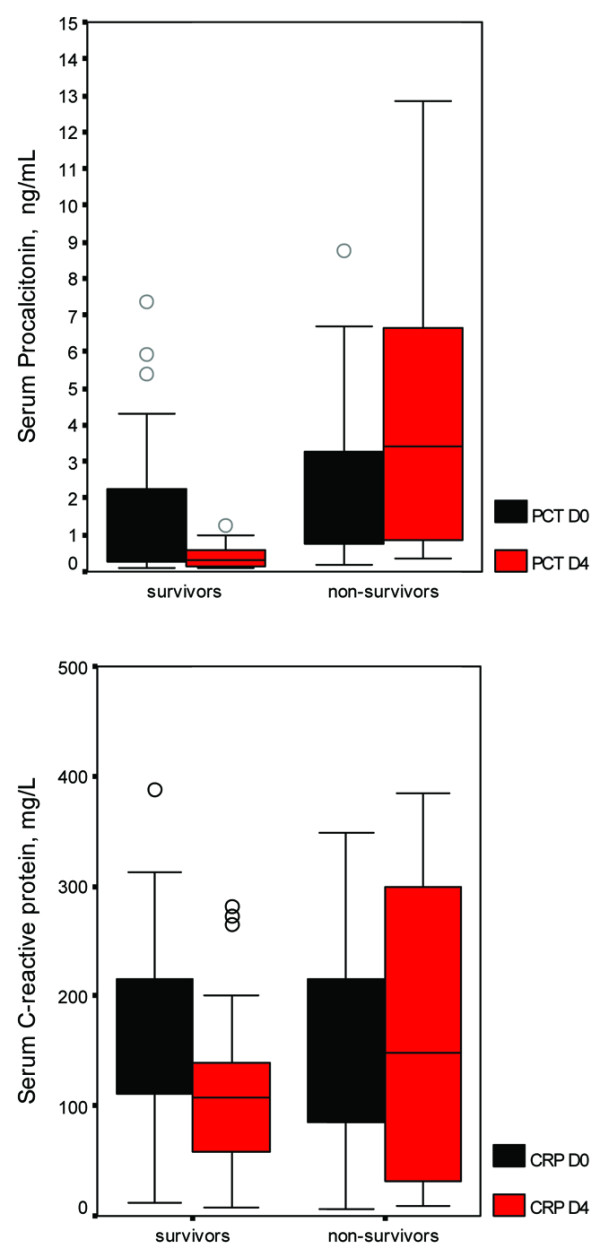
Kinetics of serum PCT (top) and CRP (bottom) in survivors and non-survivors. Box plots represent the 25th and 75th centiles; the internal horizontal line shows the median and whiskers show the 10th and 90th centiles. Circles represent outliers. Comparing between groups, p = 0.003 in D0 and p < 0.001 in D4 for procalcitonin (PCT); p = 0.77 in D0 and p = 0.14 in D4 for C-reactive protein (CRP).